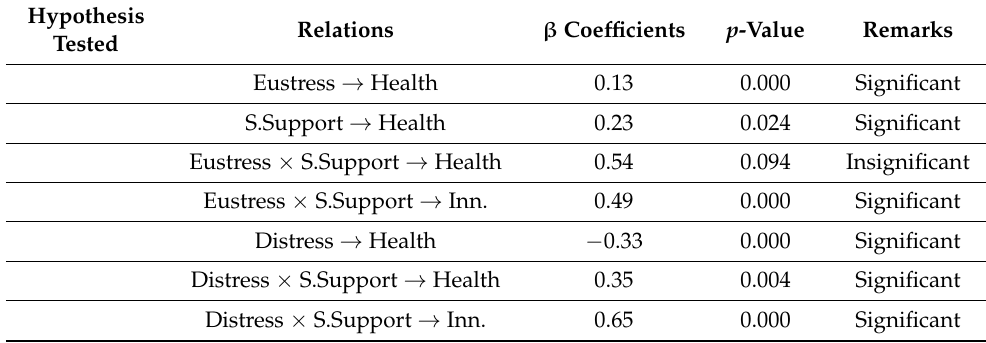
Table 8. Direct and indirect relations of studies variables.